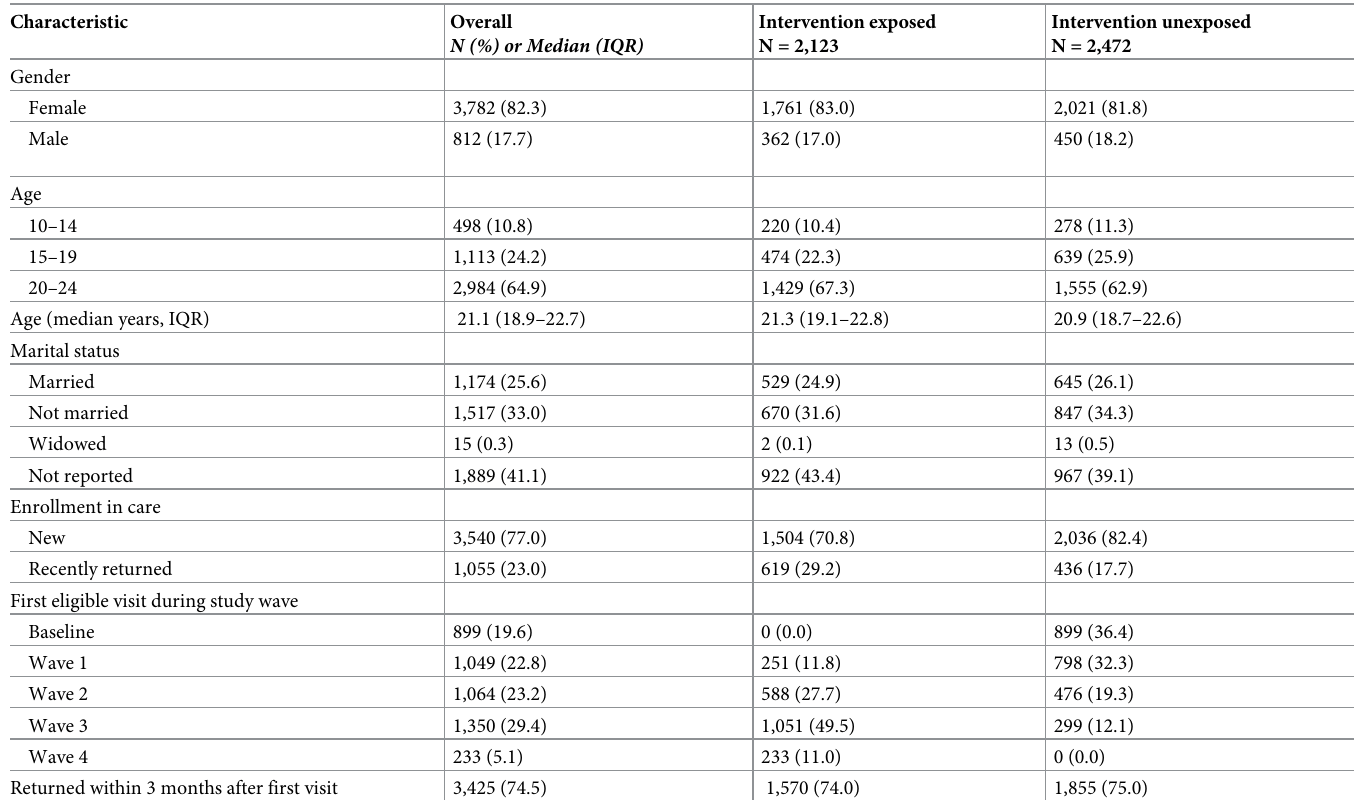
Table 4. Adolescent EMR records (n =